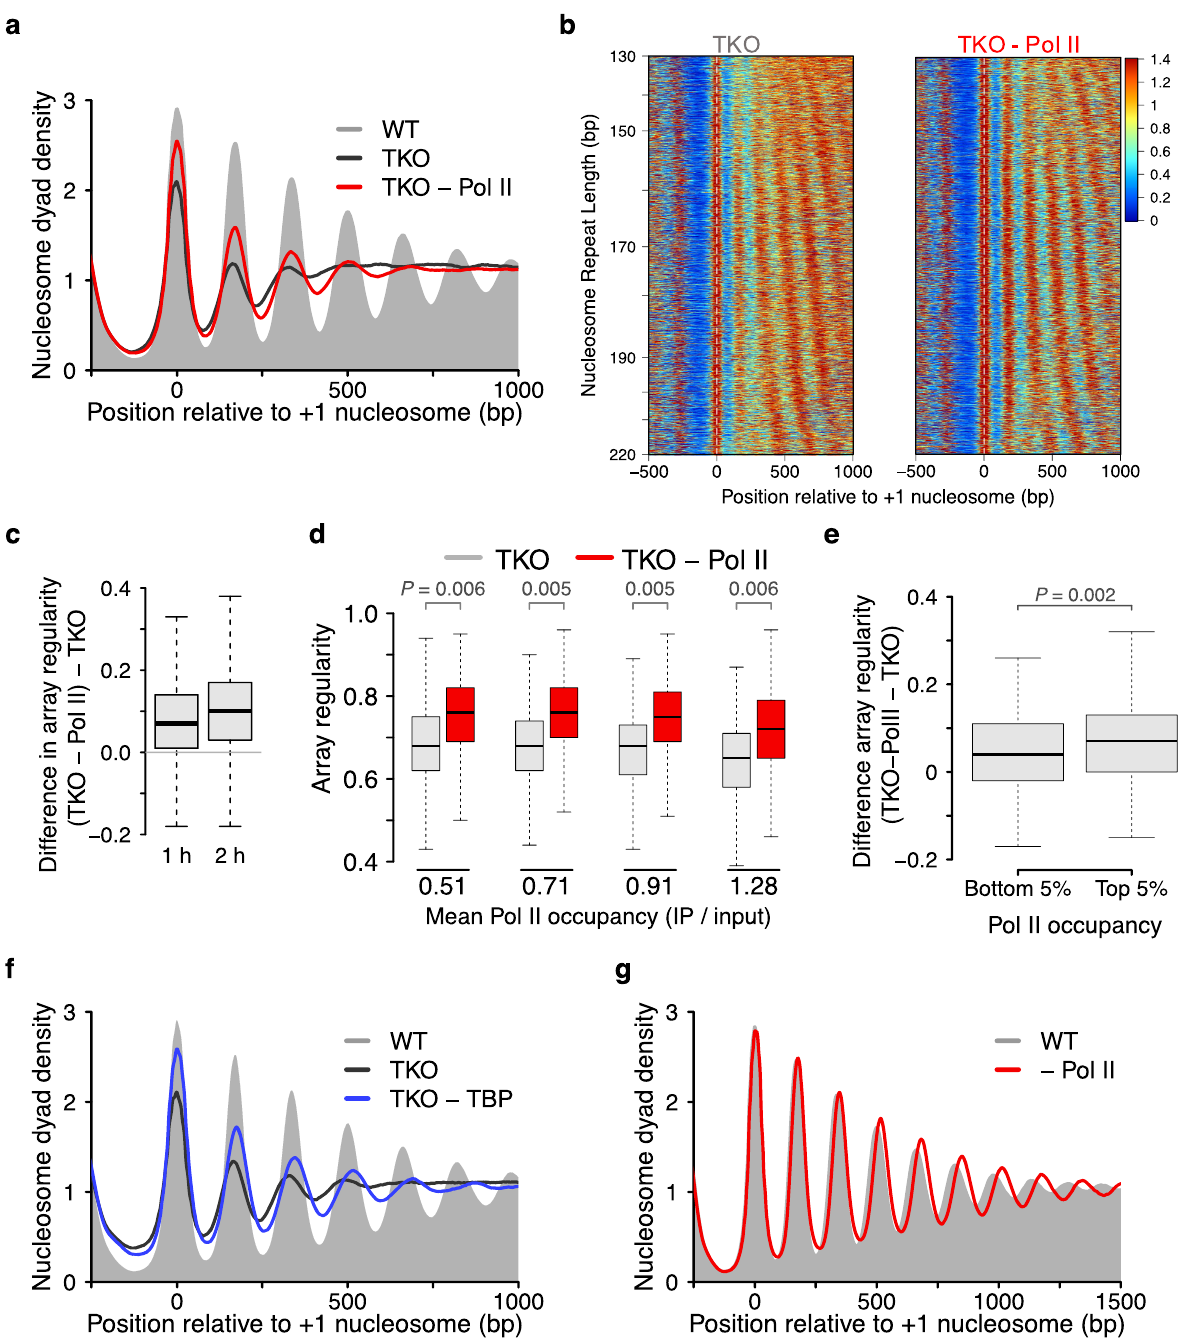
Fig. 2 Transcription disrupts the regularity of nucleosome arrays. a Pol II depletion in TKO cells using anchor-away technology elevates levels of regular nucleosome arrays (red) compared to a TKO control strain (black). A WT control strain is shown for reference (grey). Rpb1 is FRB-tagged in all strains. Cells were either rapamycin-treated or mock-treated with vehicle for 1 h. b Heatmaps for data from a . Genes were sorted according to the NRL observed in TKO cells. Color scale represents nucleosome dyad density. c Most genes acquire a higher degree of array regularity after Pol II depletion in TKO cells. Shown is the difference in array regularity for each gene before and after Pol II depletion for 1 and 2 h. Boxplot represent array regularity calculated on pooled data (three replicates for 1 h and one replicate for 2 h depletion). d Array regularity is rescued upon Pol II depletion irrespective of the transcriptional strength of genes. Genes were sorted by Pol II occupancy and divided into quartiles. Mean Pol II occupancy values of each quartile can be found underneath. Pol II occupancy data for an isw1 Δ , chd1 Δ double mutant strain served as a proxy for TKO cells 10 . Similar results were obtained when genes were sorted by gene expression 56 . Statistical analysis represents linear mixed-effect model fi tted on mean array regularity values of two replicates. e Change in array regularity upon Pol II depletion in TKO cells in genes with top and bottom 5% Pol II occupancy. P -value ( P ) represent statistical analyses performed with two-tailed Welch ’ s t -test on the mean values of three replicates. f Same as a , but for TBP depletion (1 h) in TKO cells. g Nucleosome organization upon Pol II depletion (1 h) in WT cells. Central lines in box plots indicate the median, the box shows the interquartile range, and whiskers indicate data points within 1.5× of the interquartile